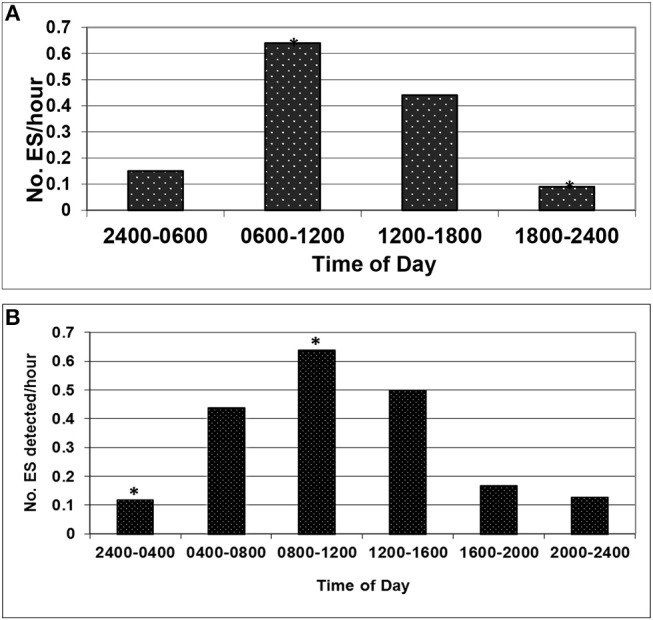
(A) The difference in rate extremes, between 0600-midday* and 1800-midnight*, was statistically significant: incidence rate ratio 7.26 (95% CI 2.52–28.64, P ≤ 0.001). (B) The difference in rate extremes, between 0800-midday* and midnight-0400*, was statistically significant: incidence rate ratio 5.52 (95% CI 1.78–22.67, P = 0.001).